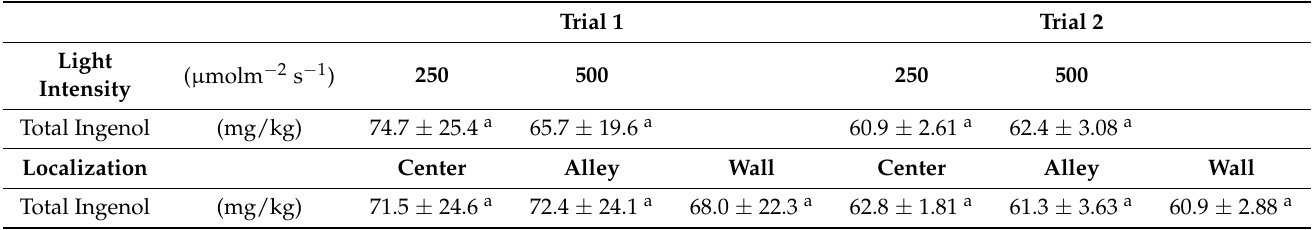
Table 2. Total ingenol mean content and standard deviation in the aerial parts of E. peplus as a function of light intensity or plant localization in two independent experiments. Total ingenol was measured in aliquots of 8 plants. Student’s comparison of means was applied with 95% confidence; means that do not share a letter are significantly different. Light intensity: Trial 1: PAR 250: N = 18 aliquots; PAR 500: N = 15 aliquots; trial 2: N = 18 aliquots. Localization: Trial 1: N = 11 aliquots; trial 2: N = 12